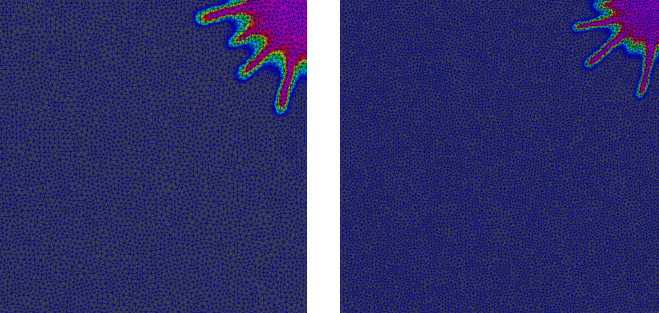
Figure 15. Impact of mesh density on damage initiation ( t in ) and subsequent evolution ( t = t in + 0.02 ms): coarser mesh left ( t in = 0.31 ms), finer mesh right ( t in = 0.22 ms).